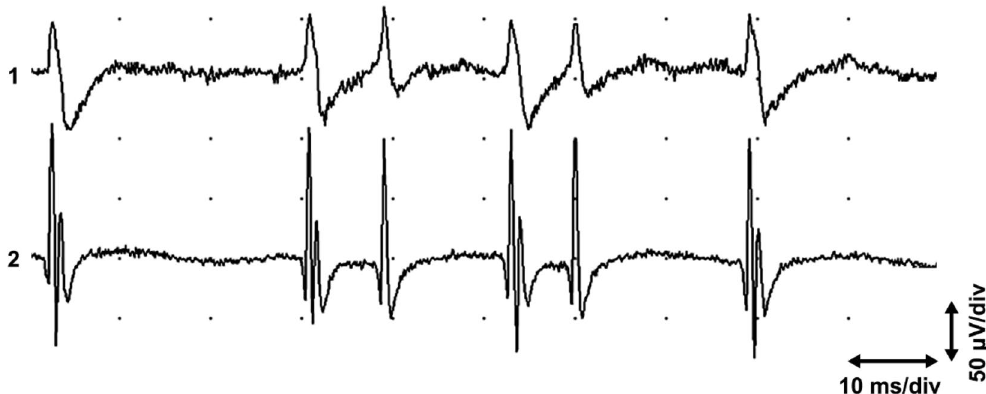
Figure 2. End plate spikes with one or two peaks in the extensor carpi radialis longus muscle. Two concentric parallel EMG needle electrodes in a fasciculus, interelectrode distance 2 mm. Two sequences of propagating “end plate spikes”, one of which shows one-peaked potential in channel 1 and two-peaked potential in channel 2, but the other shows one-peaked potential in both channels.